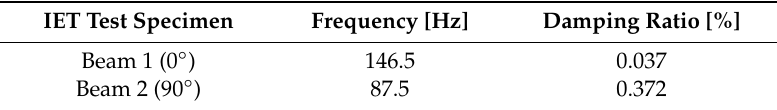
Table 2. IET test results of the two carbon / epoxy test